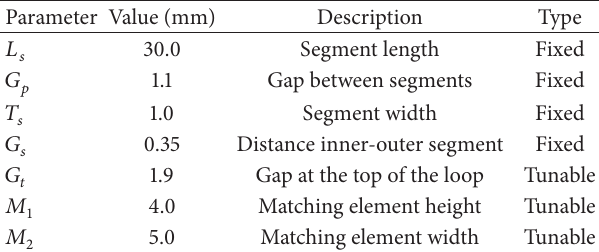
Table 1: Segmented loop antenna parameters.